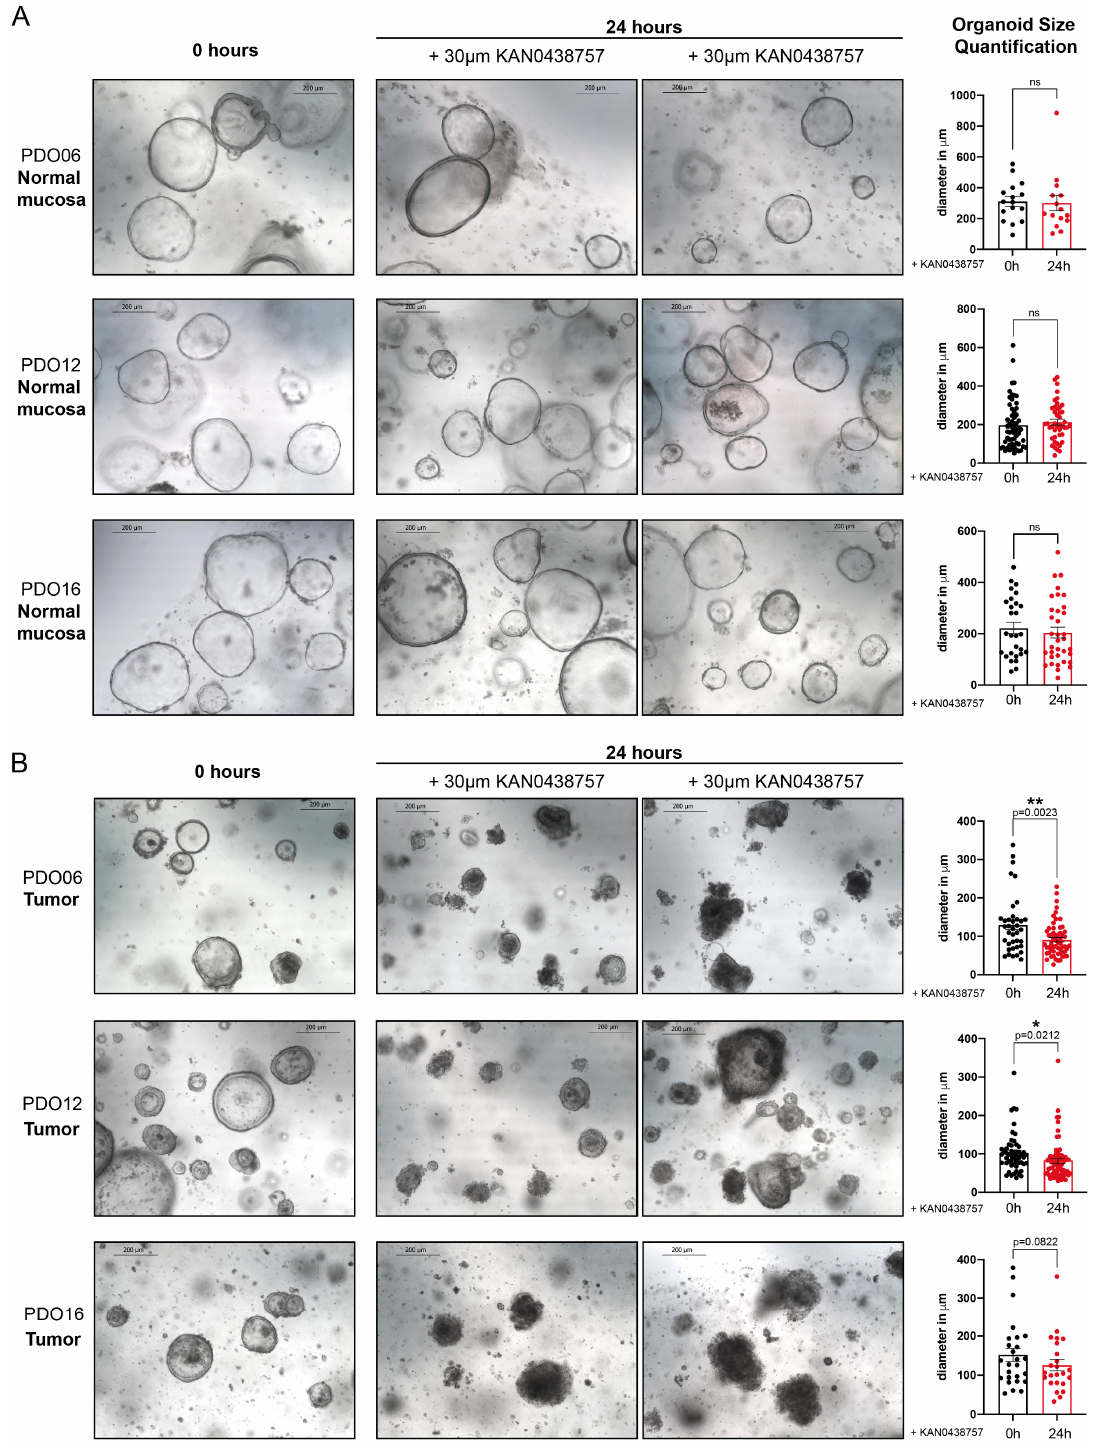
Figure 5. KAN0438757 effects on intestinal patient-derived organoids. ( A , B ) Representative pictures of normal colon (mucosa) and tumor patient-derived organoids, treated with 30 µ M KAN0438757 for 24 h and their size quantification (right-side panel). Scale bars, 200 µ m. Data is ± SEM. * p < 0.05; ** p < 0.01; ns, p >